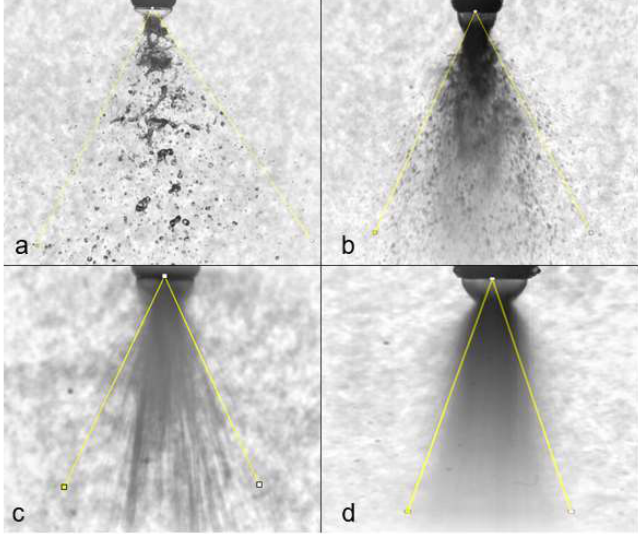
Figure 9. Spray angle measurement for the CD nozzle atomizer for two cases: ( a , c ) water and an airflow rate of 100 kg/h and 5 kg/h, respectively; ( b , d ) water and an airflow rate of 350 kg/h and 35 kg/h, respectively.